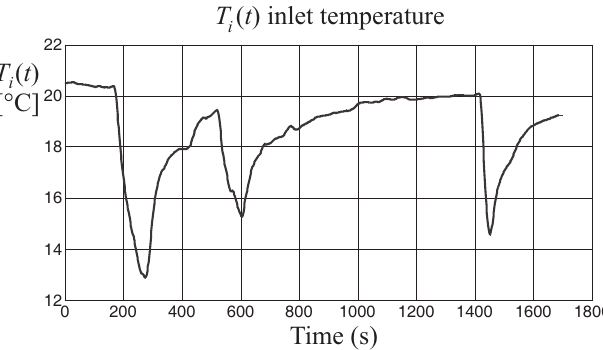
Figure 4. The inflow air temperature T i ( t ) considered as a disturbance d ( t ) acting on the controlled system.